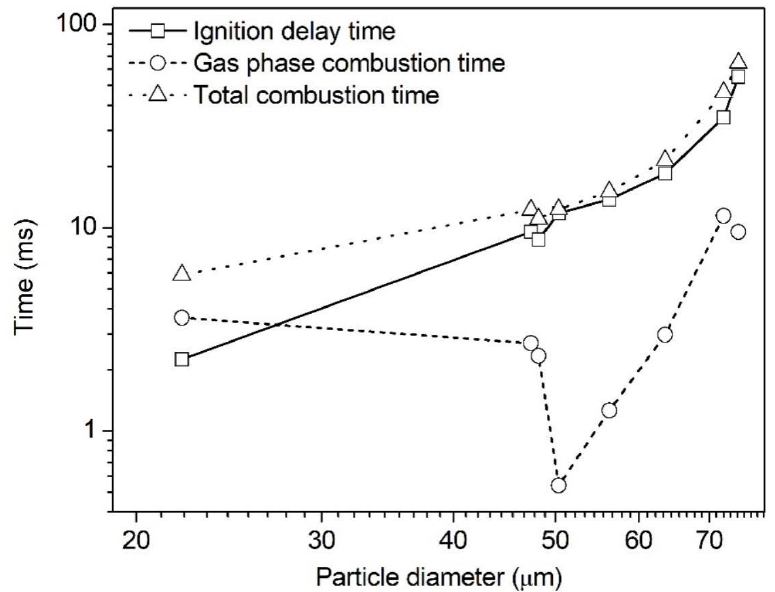
Figure 13. Characteristic ignition and combustion time of individual Mg microparticles at the same ignition power density (1.61 × 10 5 W/cm 2 ) against the particle diameter.